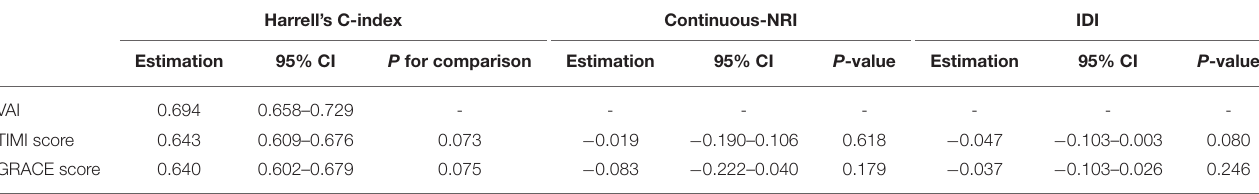
TABLE 5 | Comparison of VAI with existing risk scores on risk stratification for the primary endpoint. Harrell’s C-index Continuous-NRI IDI Estimation 95% CI P for comparison Estimation 95% CI P -value Estimation 95% CI P